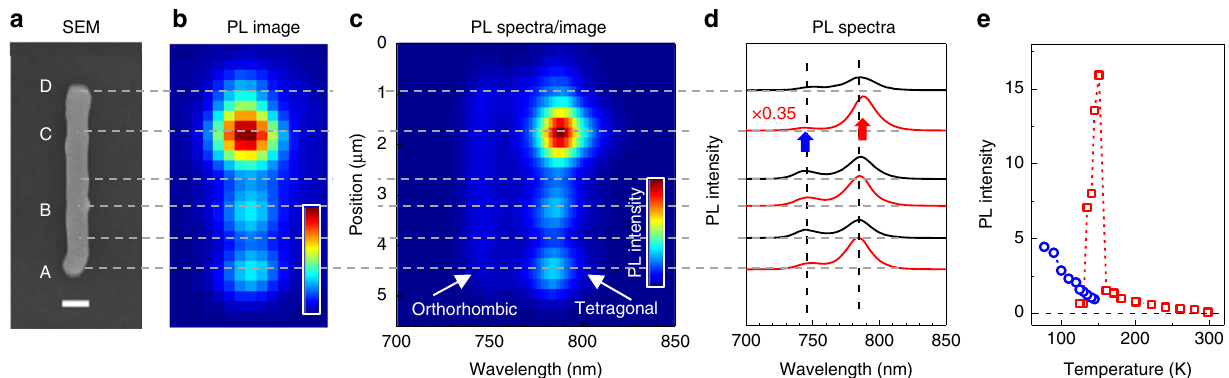
Fig. 4 Spatially resolved PL spectra of the nanowire NW#1 at 145 K. a SEM; the scale bar is 500 nm, and b luminescence images . c The PL emission intensity as a function of wavelength and emission position along the NW y-axis . The luminescence belonging to the tetragonal phase ( λ = 780 nm) is spotty , while the orthorhombic phase emission ( λ = 740 nm) is uniform . d The corresponding PL spectra collected from the different regions of the NW. e Temperature dependences of the intensities of PL bands associated with the tetragonal ( red squares ) and orthorhombic ( blue circles ) domains at spatial region C of NW#1 (spectral positions of the PL bands are marked on d by red arrows and blue arrows , respectively). Horizontal dashed lines are eye guides to mark the regions of the NW where the particular properties were measured